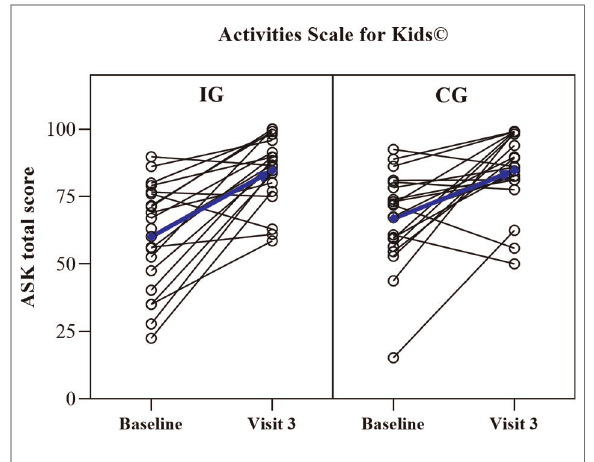
FIGURE 2 Within-participant development from the baseline (Visit 0) to Visit 3 for the activities scale for Kids© total score in the intervention (IG, n =20) and control group (CG, n =20). Blue lines represent within- group mean